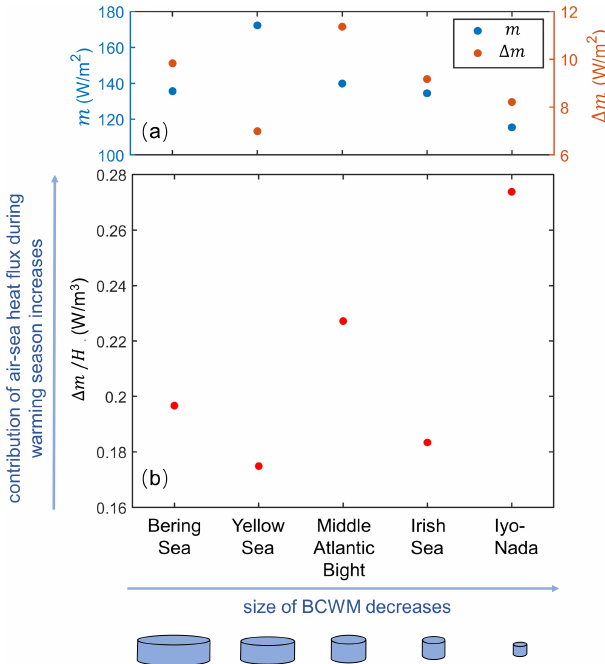
Figure 9. Values of (a) air–sea heat flux during warming season ( m ) and corresponding interannual variation ( (cid:49)m ), and (b) (cid:49)m in the five coastal seas. The cylinder at the bottom means the size of BCWM for which the horizontal and vertical are not